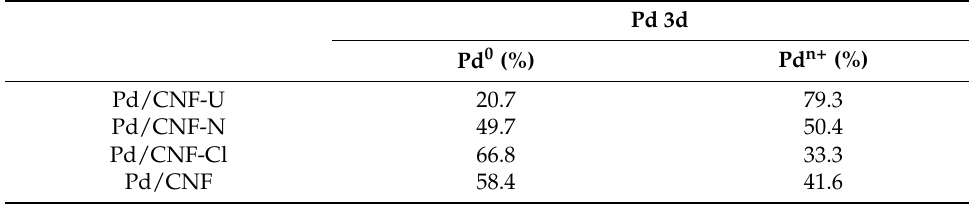
Table 4. Distribution of Pd species on the catalysts.